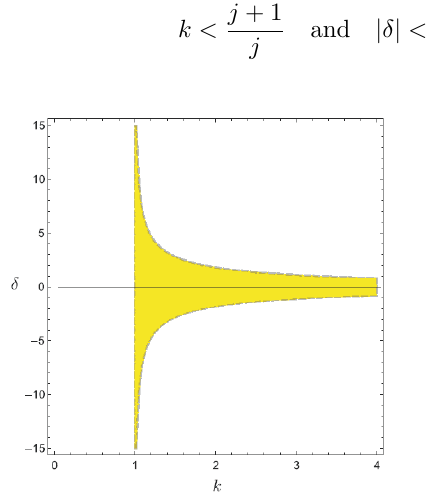
Figure 6. D 0 ( k, 1 ,δ ) is nonempty iff Figure 7. D 1 ( k, 1 ,δ ) is nonempty iff k k ( k,δ ) is in the shaded region. ( k,δ ) is in the shaded region. (cid:0) (cid:1) (cid:0) (cid:1) In Figs. 6 and 7 D 0 k, 1 , δ (cid:54) = ∅ and D 1 k, 1 , δ (cid:54) = ∅ iff ( k, δ ) is in the k k (cid:0) (cid:1) respective shaded region. In Fig. 8 the four first boundary curves Ω j k, 1 , δ of k (cid:0) (cid:1) the regions in the ( k, δ )-plane, which guarantee that the regions D j k, 1 , δ (cid:54) = k ∅ ( j = 0 , 1 , 2 , 3) are depicted. If k = 1 . 08, l = 1 and δ = 13 . 88, the only two k “good” regions D 2 ( k, l, δ ) and D 3 ( k, l, δ ) are nonempty, see Fig.